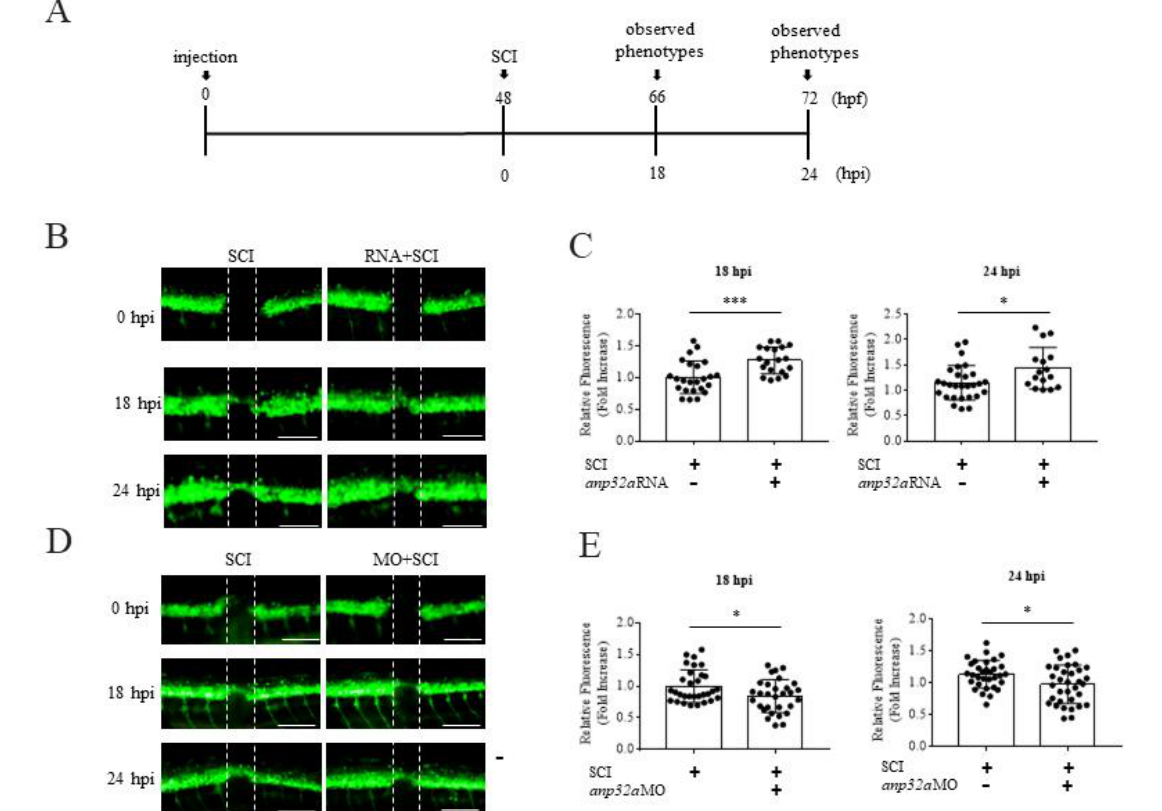
Figure 3. Anp32a is required for the neuronal regeneration of zebrafish larvae after SCI. ( A ) The experimental flowchart showing the time course of microinjection of either Anp32a mRNA or Anp32a morpholinos, SCI performance and observation of spinal cord regeneration. Embryos at the one-cell stage were injected with either wobble- Anp32a -flag mRNA or antisense morpholino oligonucleotides (MO) of Anp32a and SCI at 48 hpf, followed by analysis of the lesion gap at 0, 18 and 24 hpi. ( B ) Time course image of spinal cord regeneration in control embryos and Anp32a -overexpressed embryos at 0, 18 and 24 hpi. ( C ) Quantification of temporal regenerative response in SCI-control and wobble- Anp32a -flag mRNA-injected embryos at 18 hpi (left; control: n = 25; RNA + SCI: n = 19) and 24 hpi (right; control: n = 28; RNA + SCI: n = 16). ( D ) Time course image of spinal cord regeneration in control embryos and Anp32a -morphants at 0, 18 and 24 hpi. ( E ) Quantification of temporal regenerative response in SCI control embryos and Anp32a -morphants at 18 hpi (left; control: n = 31; MO + SCI: n = 30) and 24 hpi (right; control: n = 32; MO + SCI: n = 34). Scale bar: 100 μ m; The Student’s t -test was used to perform statistical analysis (*, p < 0.05; p < 0.01; ***, p < 0.001; error bars indicate mean ± SD).